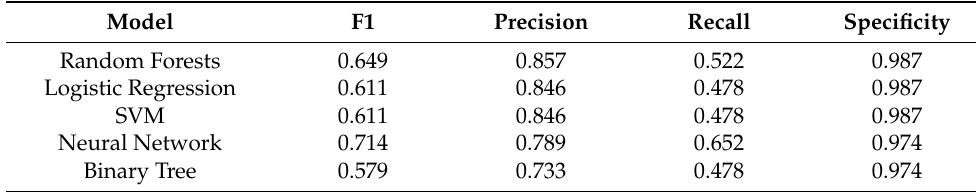
Table 9. Models accuracy metrics for add to cart action (class 1) with add_to_cart_both as target parameter.